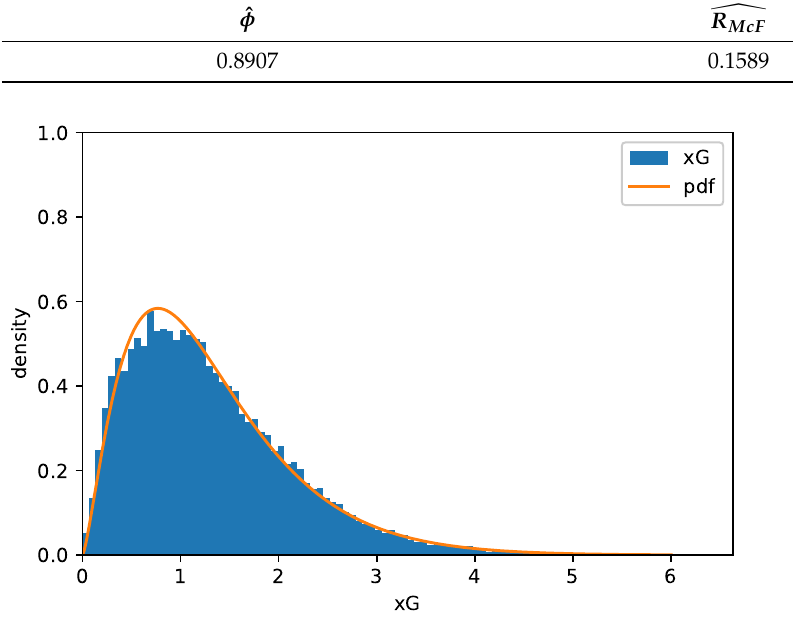
Figure 1. Distribution of